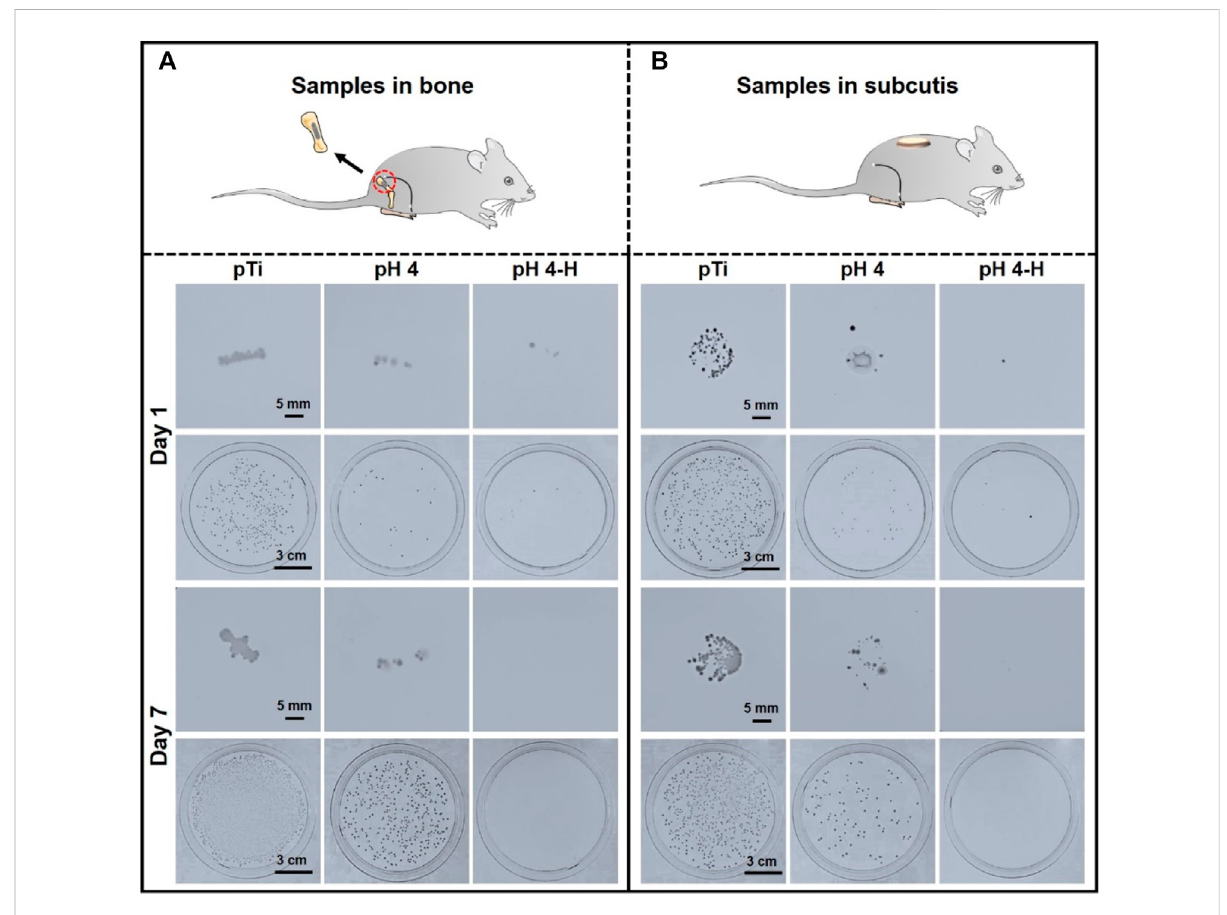
FIGURE 4 In-vivo antibacterial assay of the pH 4 and pH 4-H treatments: (A) Titanium rods dipped in bacteria solution were implanted into the femoral medullary cavityofratmodelsfor oneand7 days; (B) titaniumdiscsdipped inbacteriasolutionwereimplanted intothesubcutaneous locationofrat models for one and 7